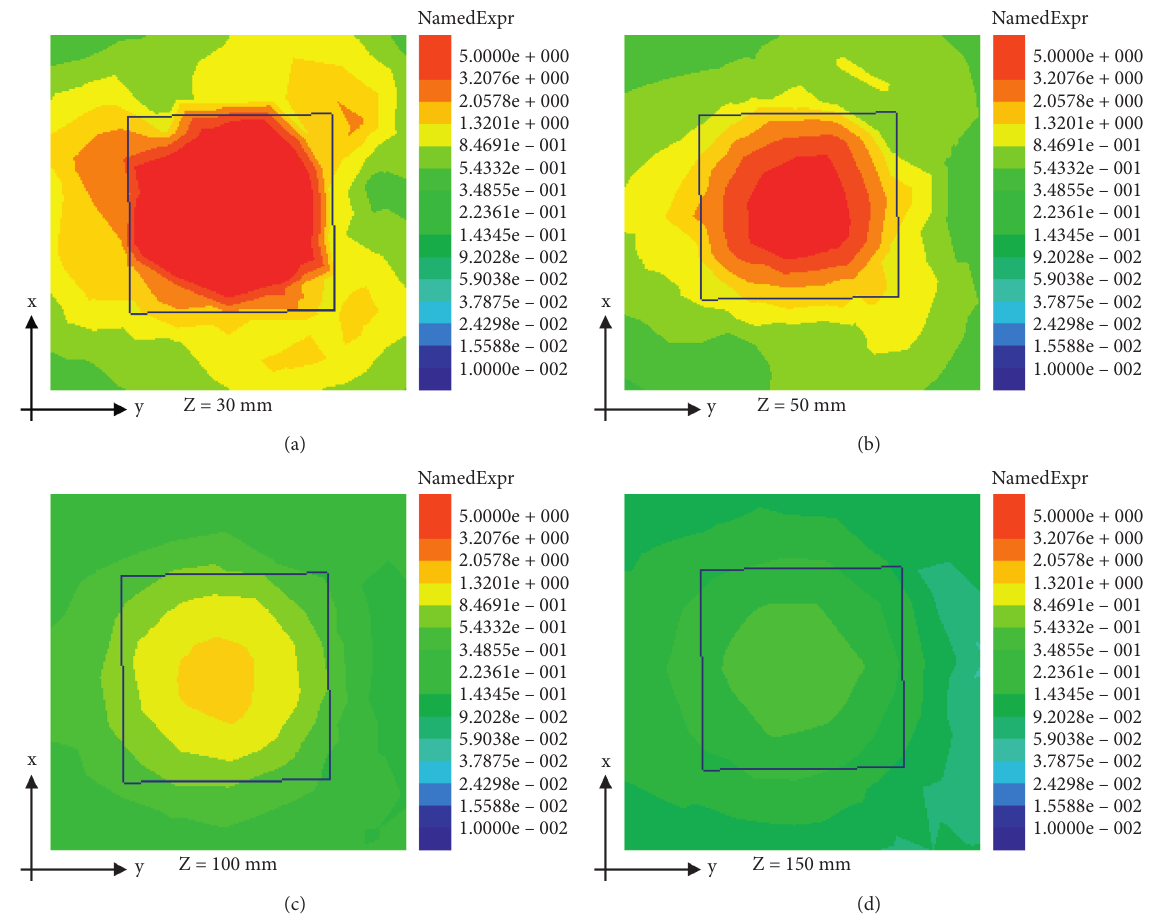
Figure 20: Simulated Ez distributions of the three-branch antenna at different heights when the dielectric constant is 5. (a) Z � 30mm. (b) Z � 50mm. (c) Z � 100mm. (d) Z �